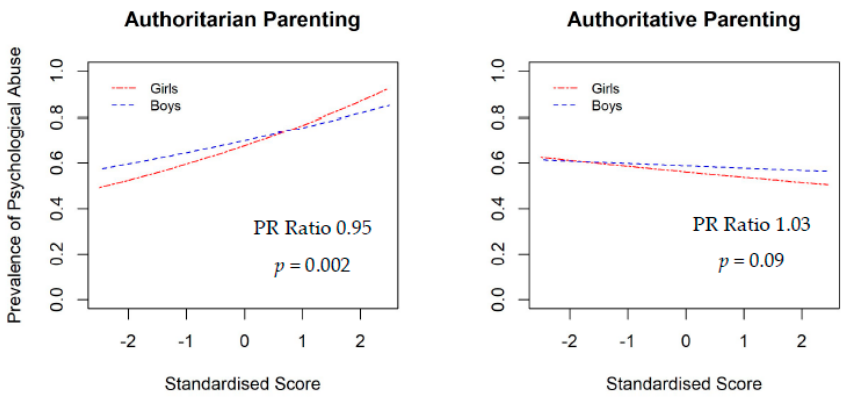
Figure 2. Moderation effect of child gender on the association between parenting style and child maltreatment.